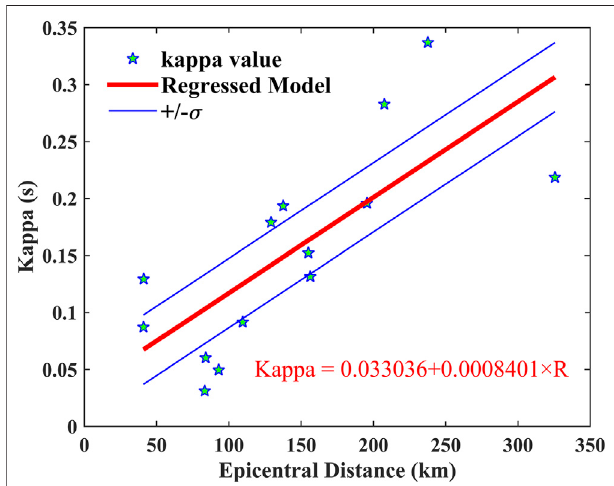
FIGURE 2 | Dependence of spectral decay parameter κ on epicentral distanceforhorizontalcomponentintheJiuzhaigouearthquake.Thelightblue fi ve-pointed star represents the kappa value obtained from each station recording, and the red solid line represents the regressed model.